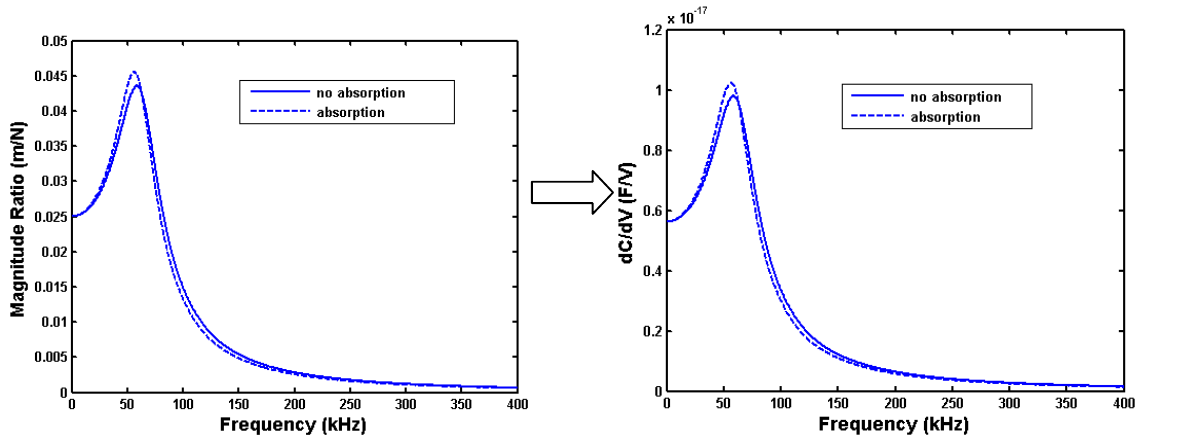
) for 200 μ m × 200 μ m × s = 51.65 N/m,  m / m flex